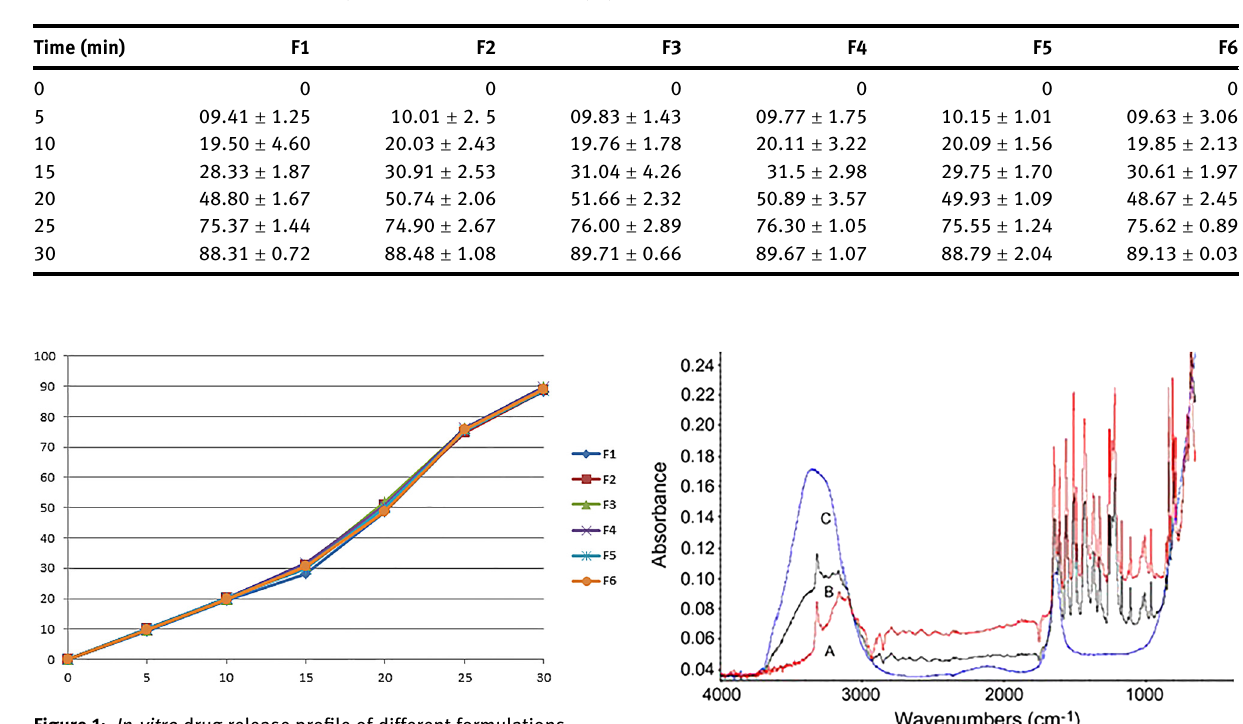
Table  : In-vitro dissolution data of paracetamol medicated lollipops.